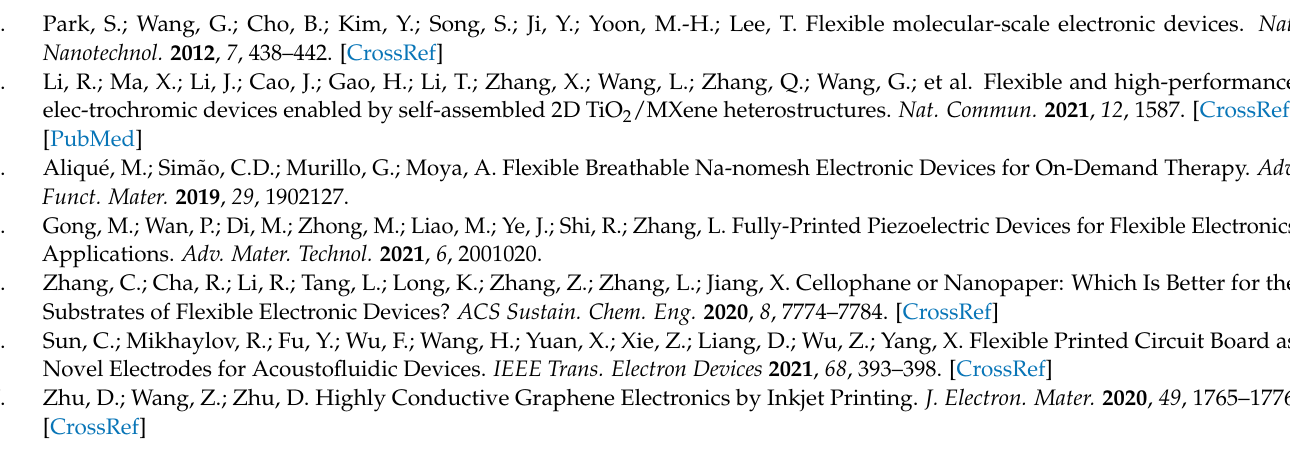
of ink box, Figure S3: Photograph of ink box at work, Figure S4: Photographs of the printed patterns without heat treatment with ink droplets spacing of 5 (a), 15 (b), and 20 µ m (c), respectively, Figure S5: Photographs of the printed patterns with 0.57 (a), 0.74 (b), and 0.91 mg · mL − 1 (c) of AgNWs inks,